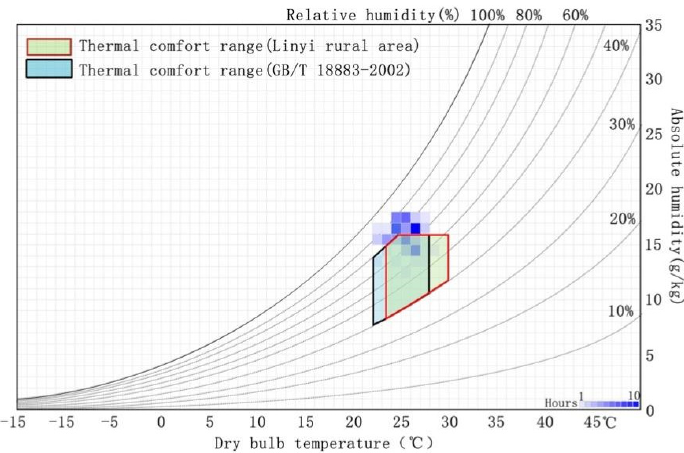
Figure 25. Comparison of thermal comfort zone in summer.